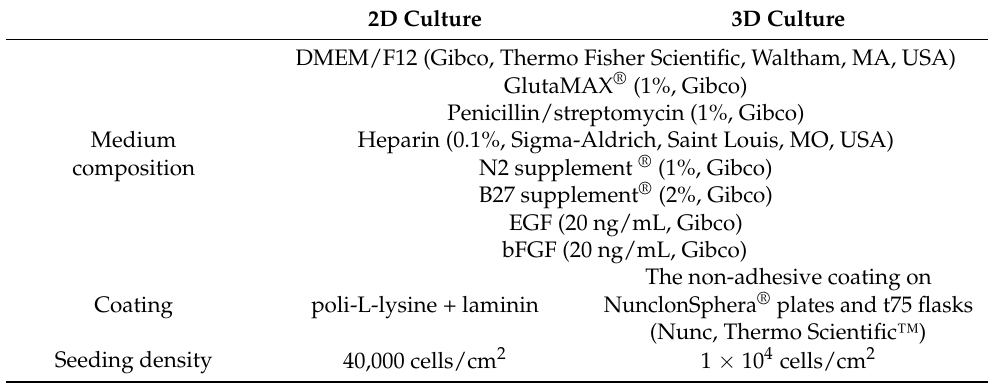
Table 1. The medium composition, coating, and seeding density used in the following